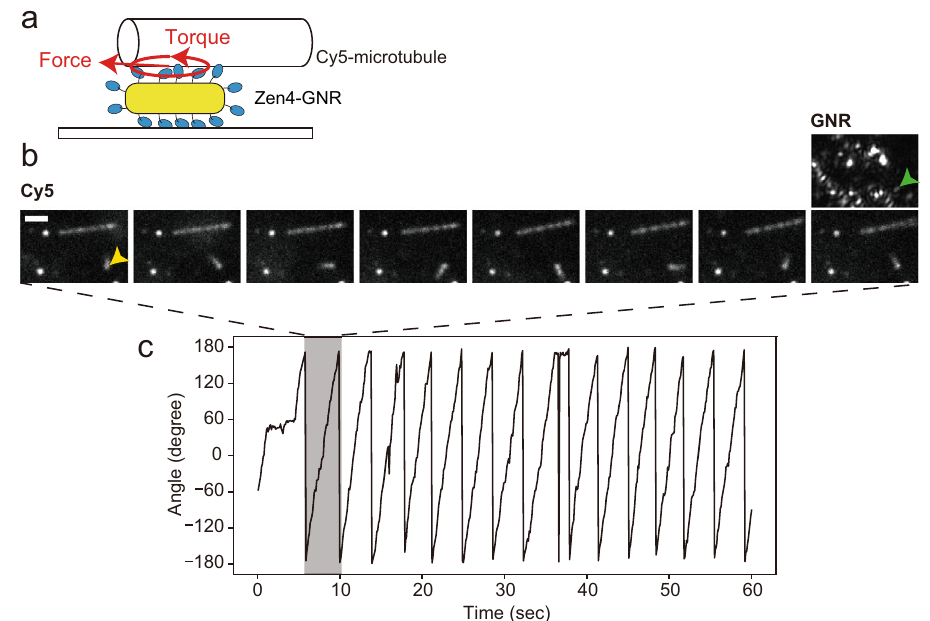
Fig. 6 Surface-gliding assay for ZEN-4 coated gold nanorods (ZEN4-GNRs). a Schematic drawing of the surface-gliding assay, whereby the generation of force and torque rotate a Cy5-labeled microtubule (Cy5-microtubule) on the ZEN4-GNR. b Montage of fl uorescence images of Cy5-microtubules every six frames (600 ms), showing that the short Cy5-microtubule continuously rotated (yellow arrowhead). Scale bar 2 μ m. GNR image of the same region-of- interest of the Cy5 images is also shown (green arrowhead). c Time trajectory of the microtubule